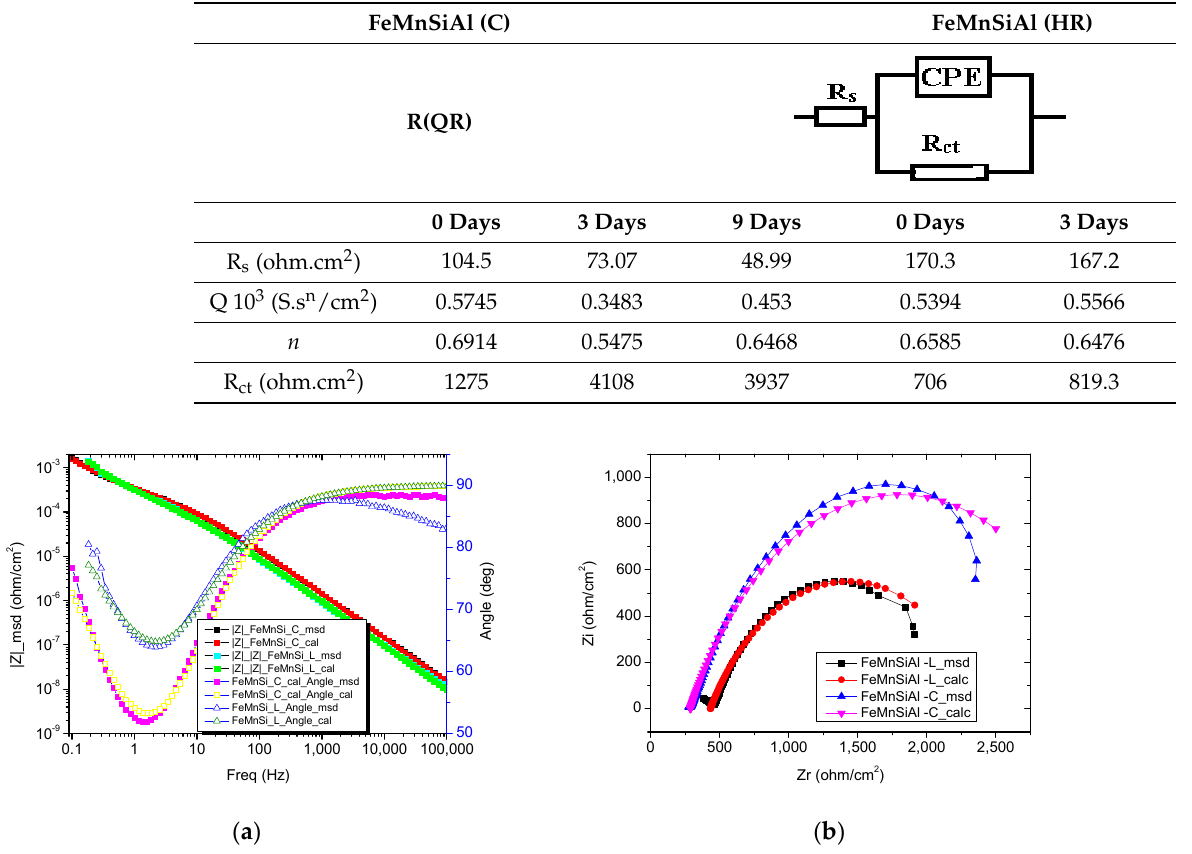
Figure 9. Electrochemical measurements of tested samples for: ( a ) Bode plots; ( b ) Nyquist plots after 1 h in Ringer solution.